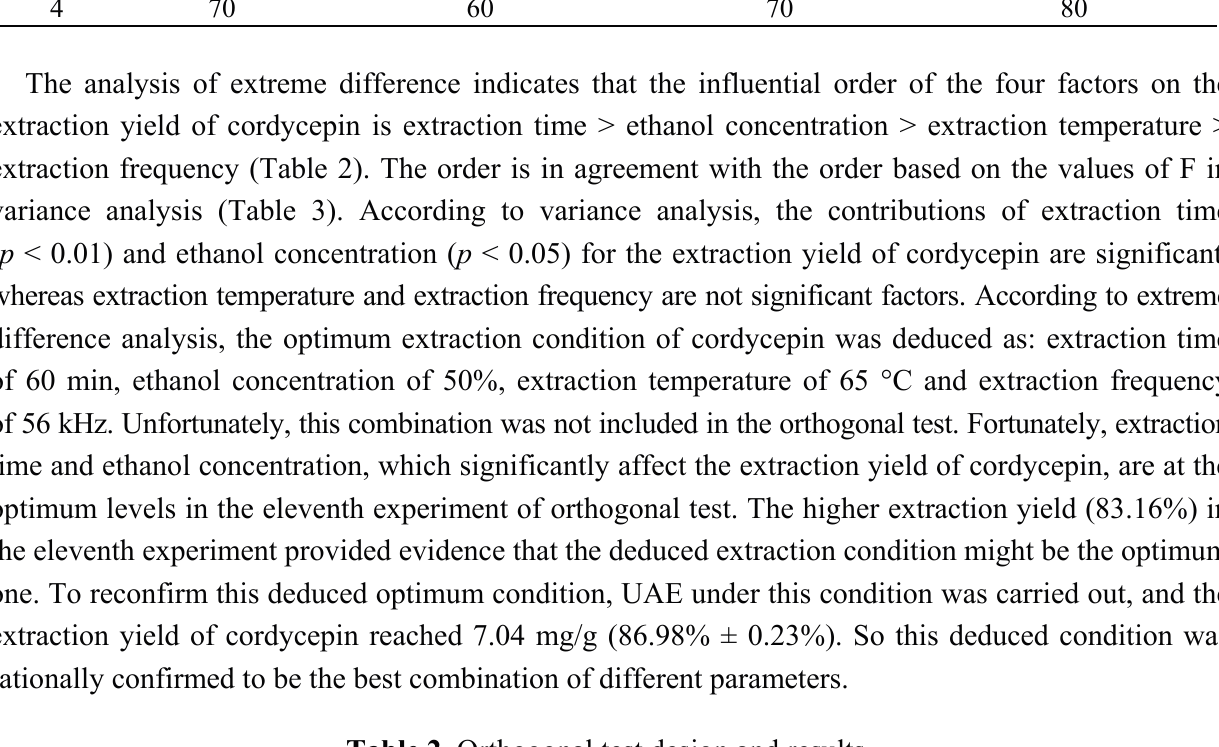
Table 2. Orthogonal test design and